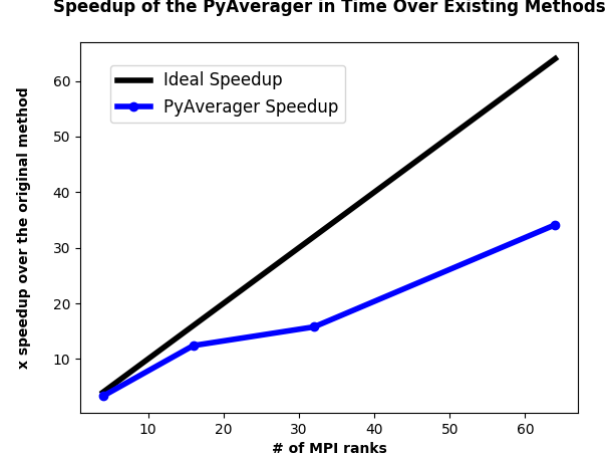
Figure 6. The comparative speedup of creating climatology files from 10 years of monthly atmospheric data. Four seasonal and twelve monthly climatology files were created. For comparison, the original methods took approximately 26.5min to generate the cli- matologies. The PyAverager took approximately 46s to create the same climatologies with 64 MPI